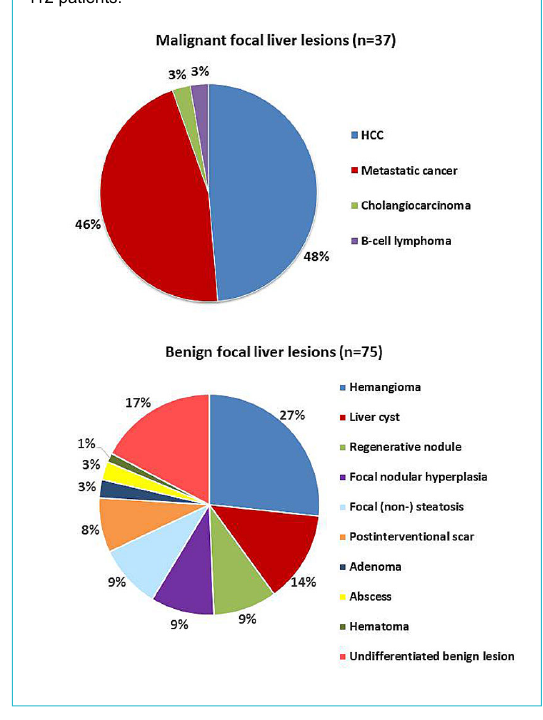
Figure 2: Aetiology of malignant and benign focal liver lesions in 112